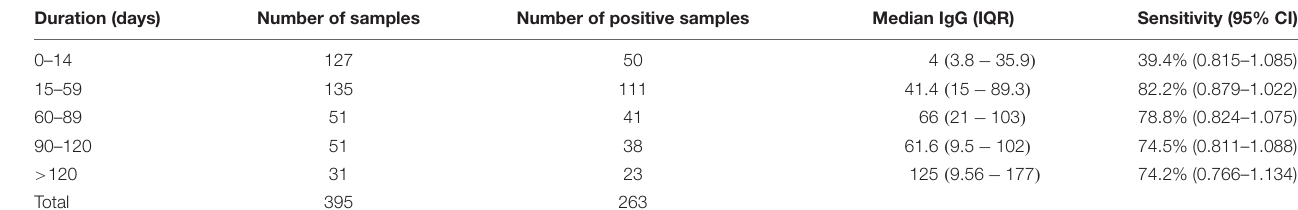
TABLE 4 | Number of serological assays performed across different time points and their median IgG levels. Duration